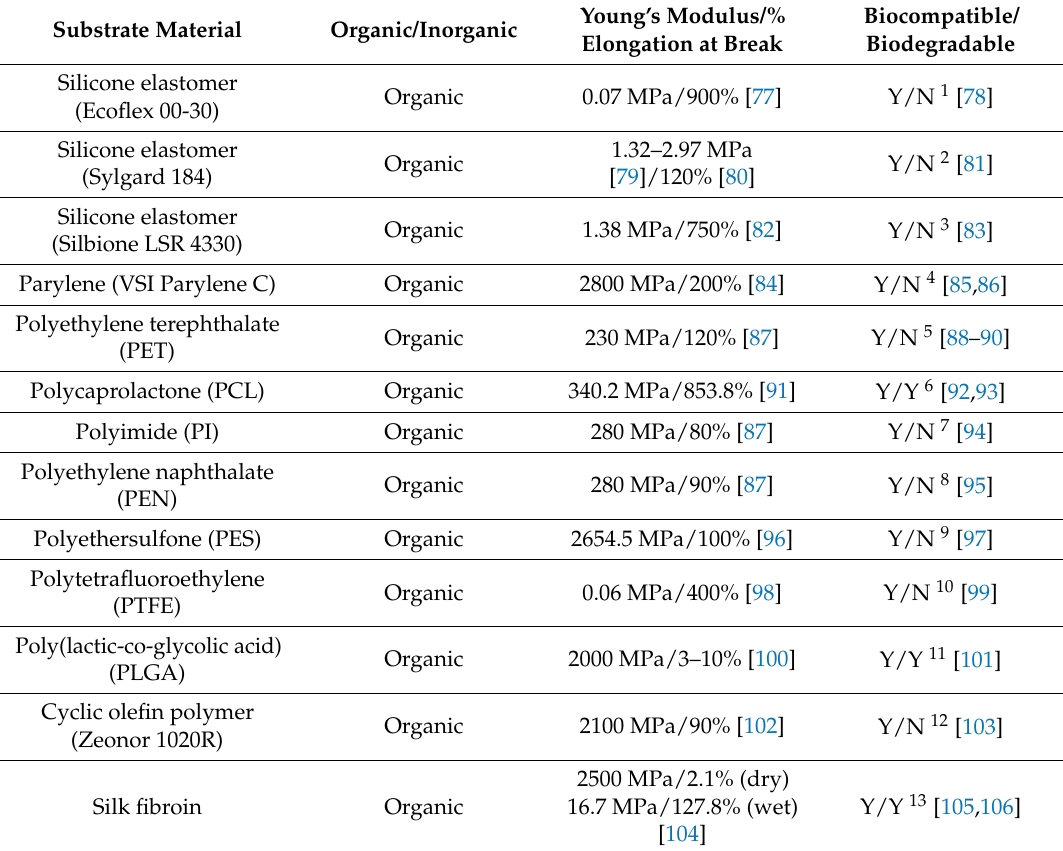
Table 2. Substrate materials and their properties for wearable and implantable